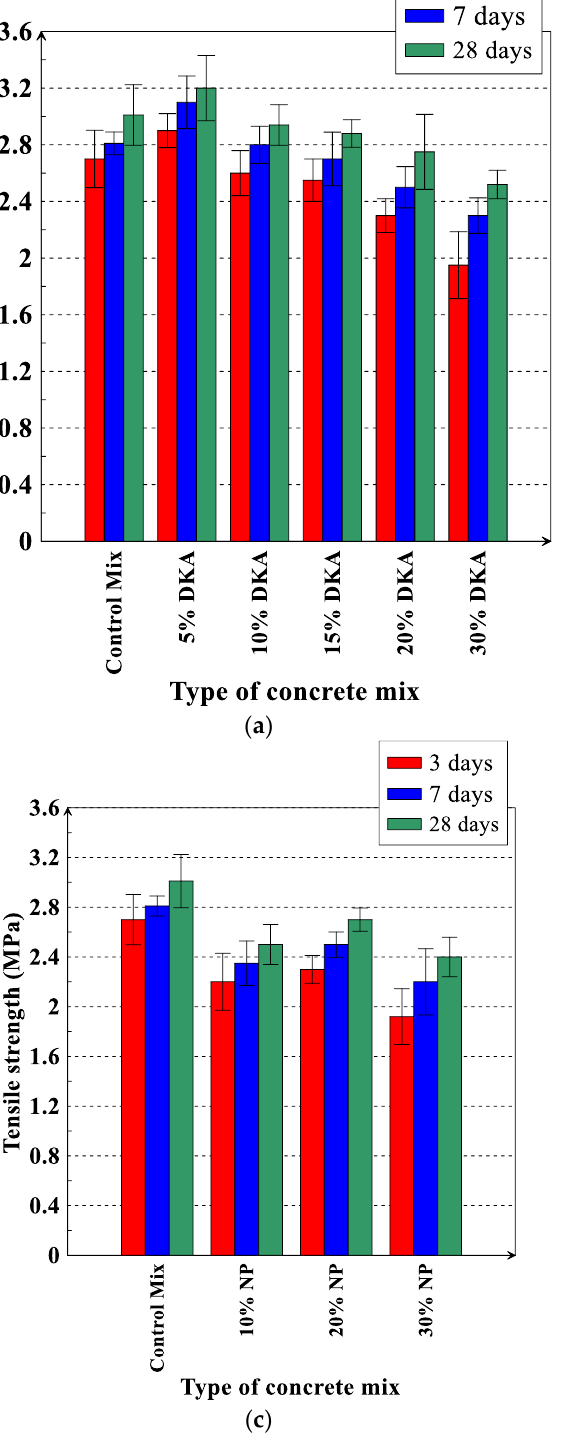
Figure 24. Tensile strength of concrete mixtures for ( a ) DKA, ( b ) FA, and ( c ) NP. Error bars represent one standard deviation from the average of three specimens.